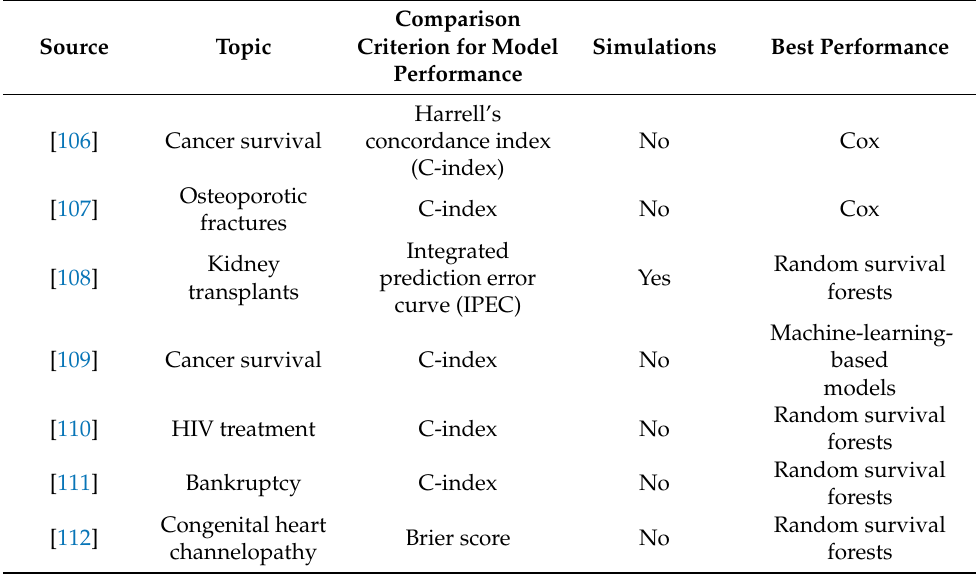
Table 2. Overview of studies comparing Cox regressions and random survival